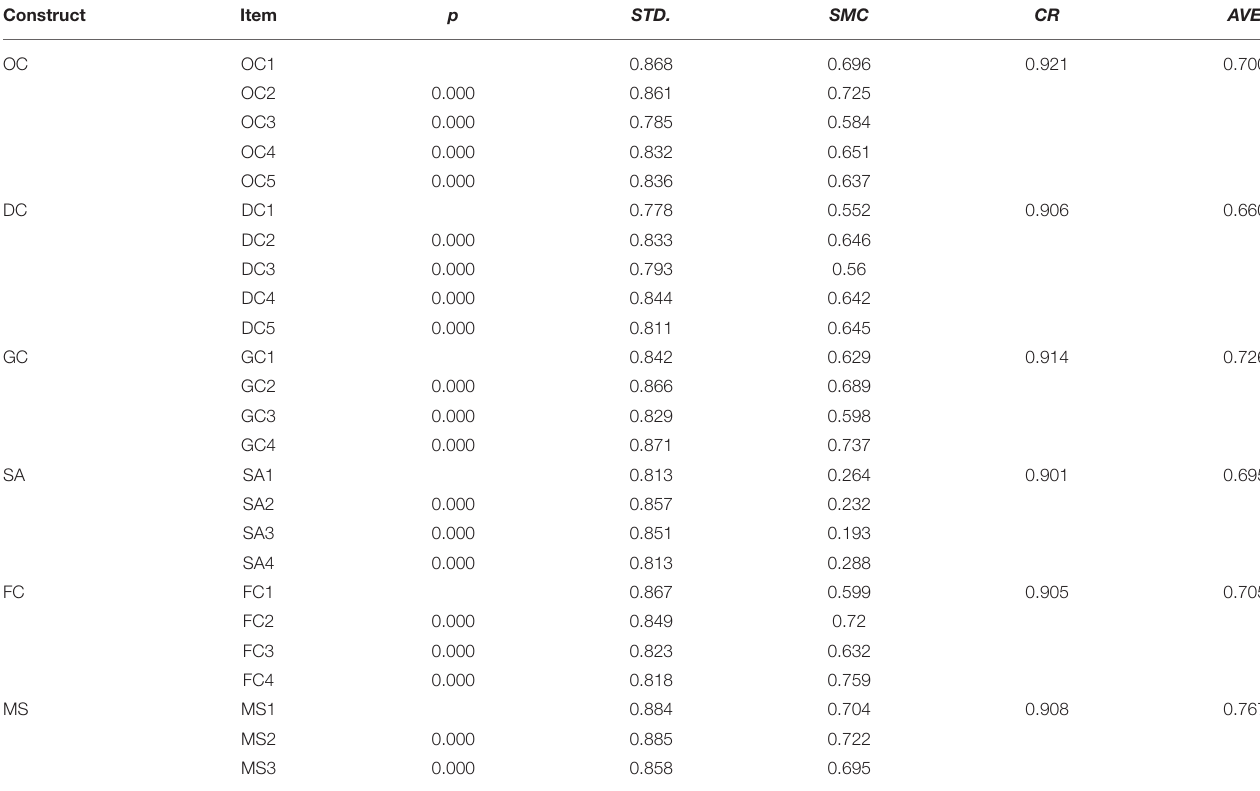
TABLE 2 | Confirmatory factor analysis.